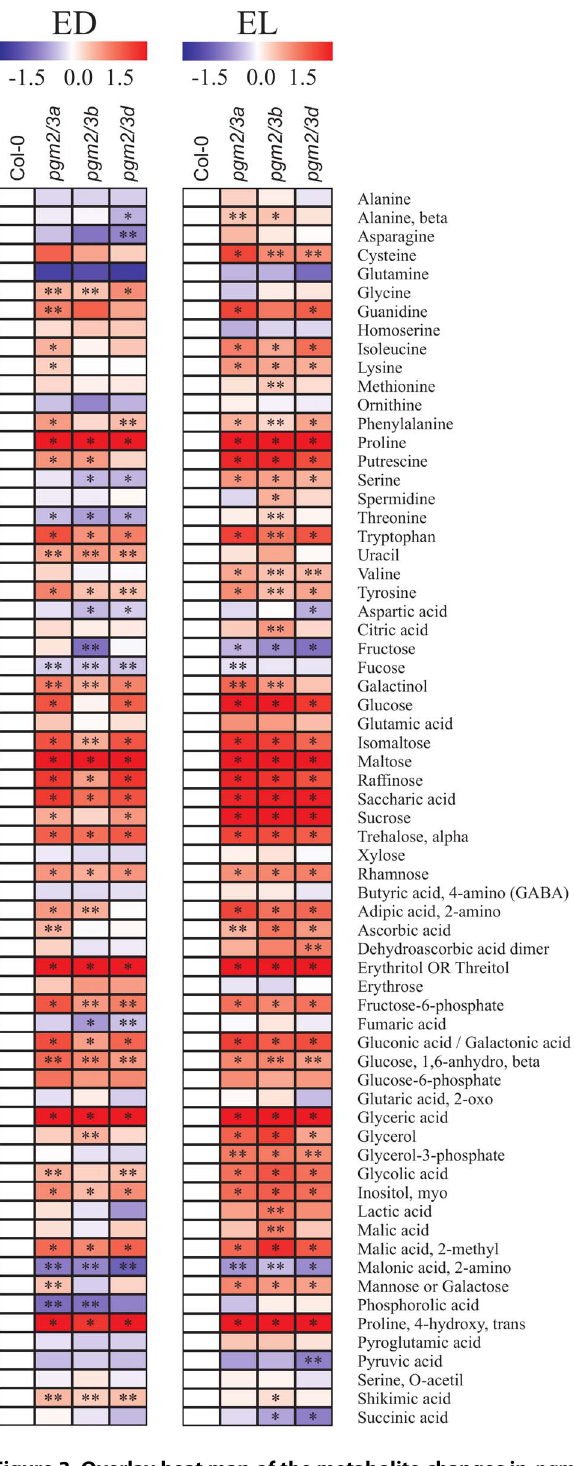
Figure 3. Overlay heat map of the metabolite changes in pgm2/ 3 mutants in comparison with control (Co1-0) using false-color scale. Red or blue indicate that the metabolite content is increased or decreased, respectively. Five-week-old plants were grown under 12 h light/12 h dark conditions and harvested at the end of light phase (EL) and dark phase (ED), and three replicates represented 3–4 plants were analyzed (two technical replicates each); asterisks denote the signifi- cance levels as comparing pgm2/3 mutants to Co1-0 : * p # 0.01; ** p # 0.05.